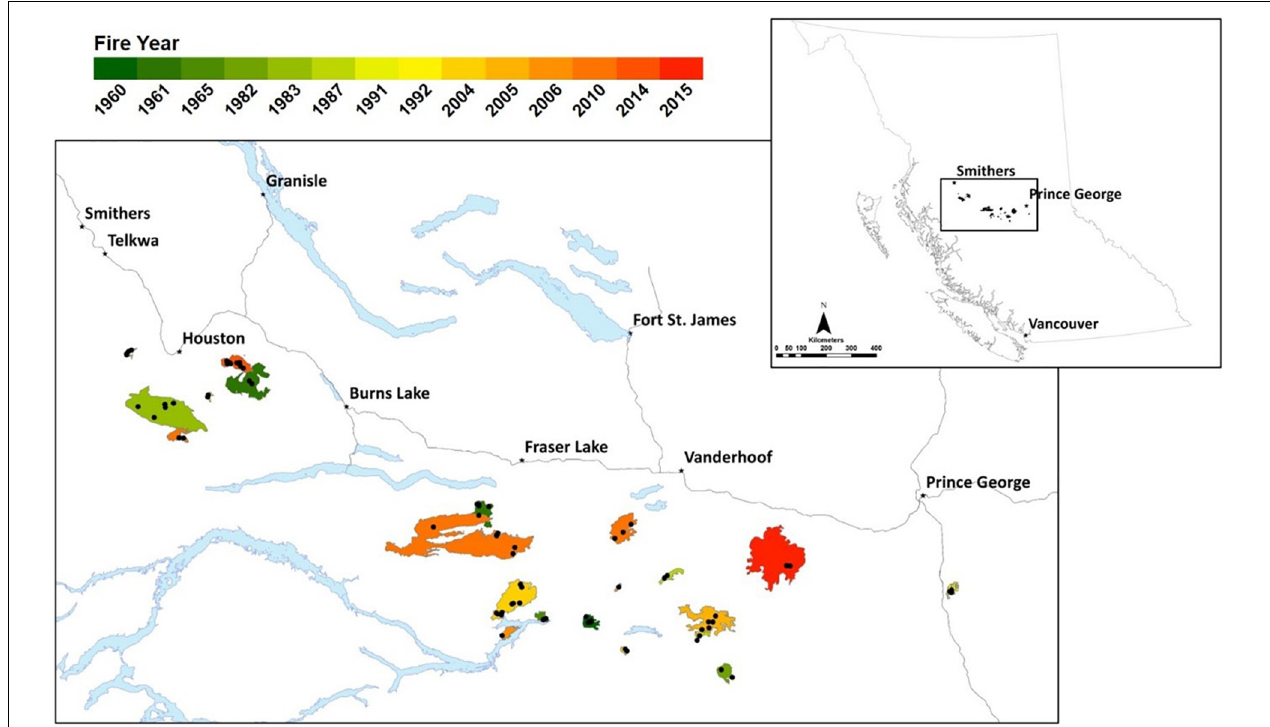
FIGURE 1 | The study area spans the central interior of British Columbia, with study fire perimeters colored by fire year, and black points indicating plot locations within fires.